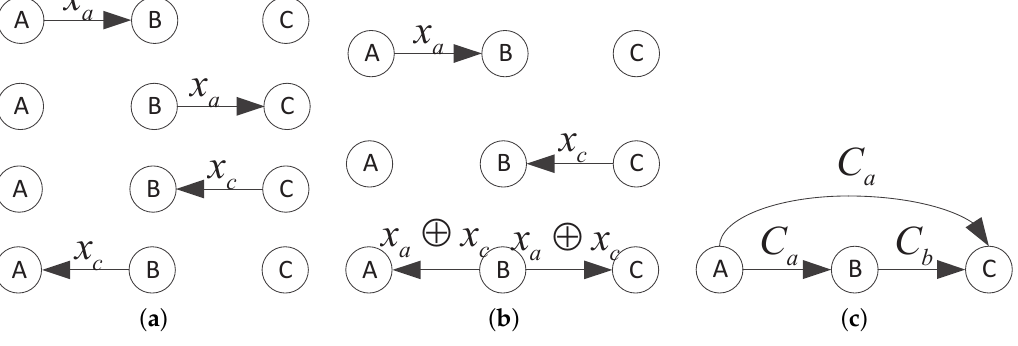
Figure 4. ( a ) The conventional approach of multi-casting; ( b ) The network coding approach of bi-direction transmission; ( c ) The network coding approach for unidirectional